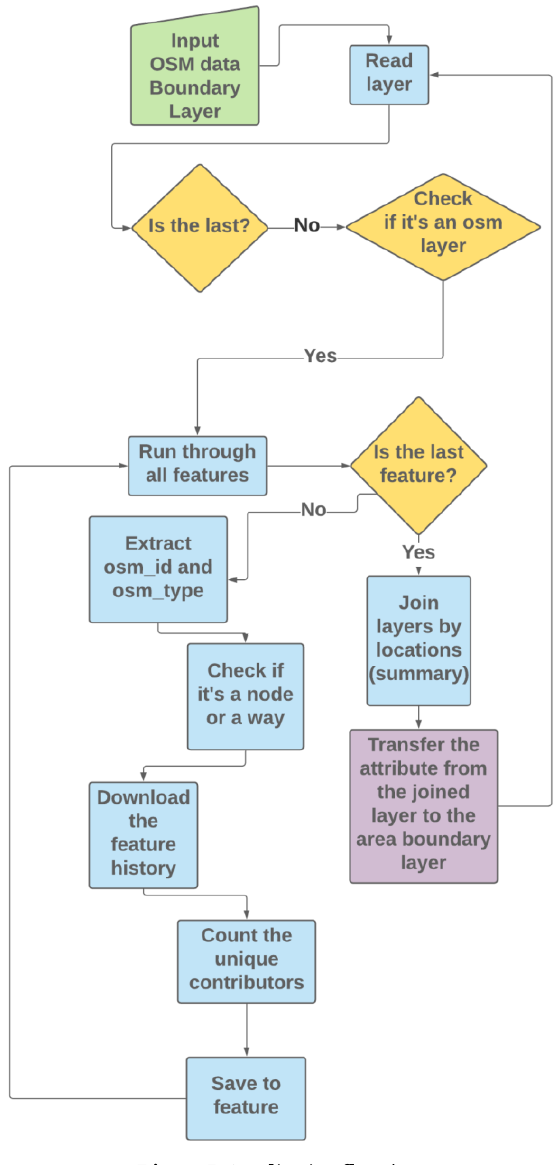
Figure 5. Application